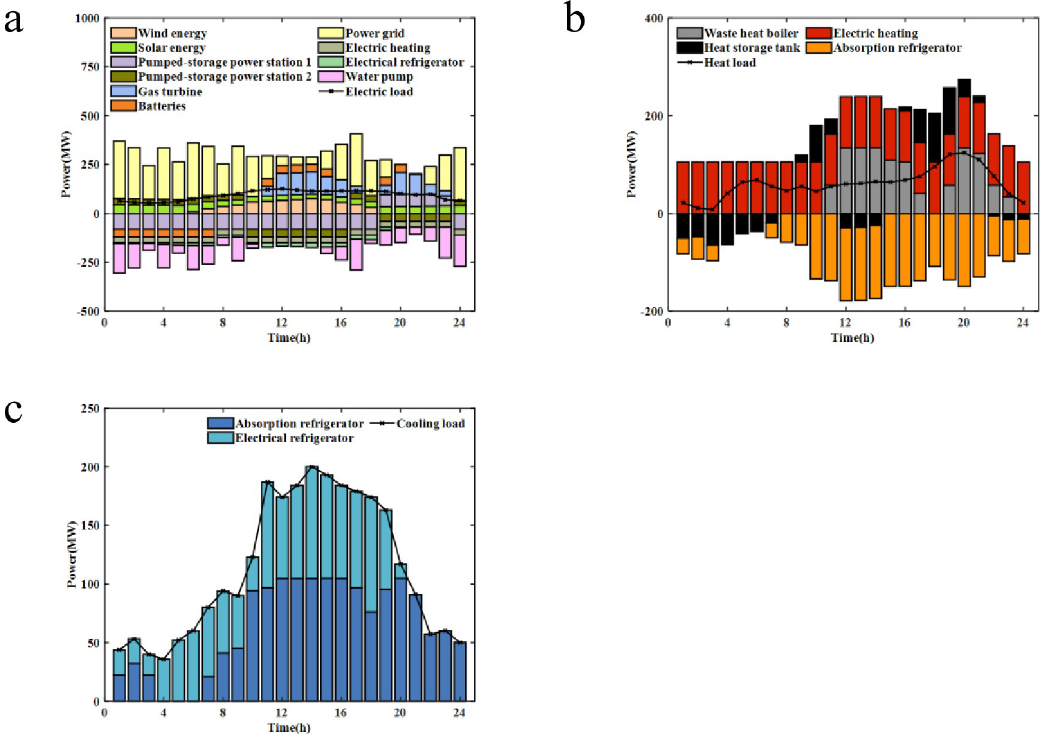
Fig 8. Balance of electrical/heat/cold load: (a) Balance of electrical load, (b) Balance of heat load, (c) Balance of cold load.